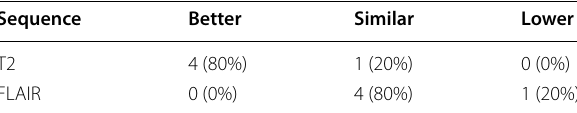
Table 5 classifying visually assessed lesions on patients with gliosis according to visibility on DIR compared to the T2 and FLAIR Sequence